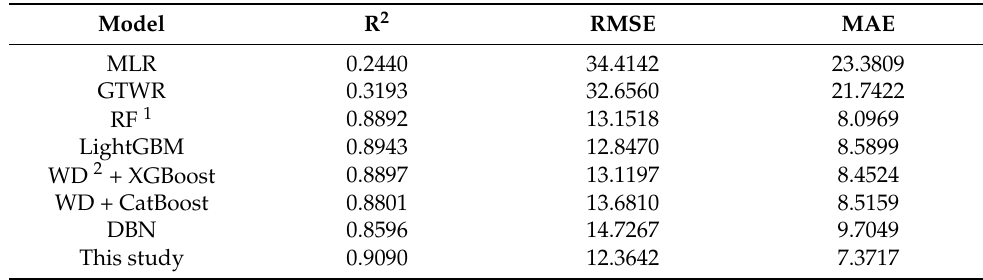
Table 5. Comparing the performance of different models for PM 2.5 concentration estimation in the Beijing–Tianjin–Hebei region in 2020.